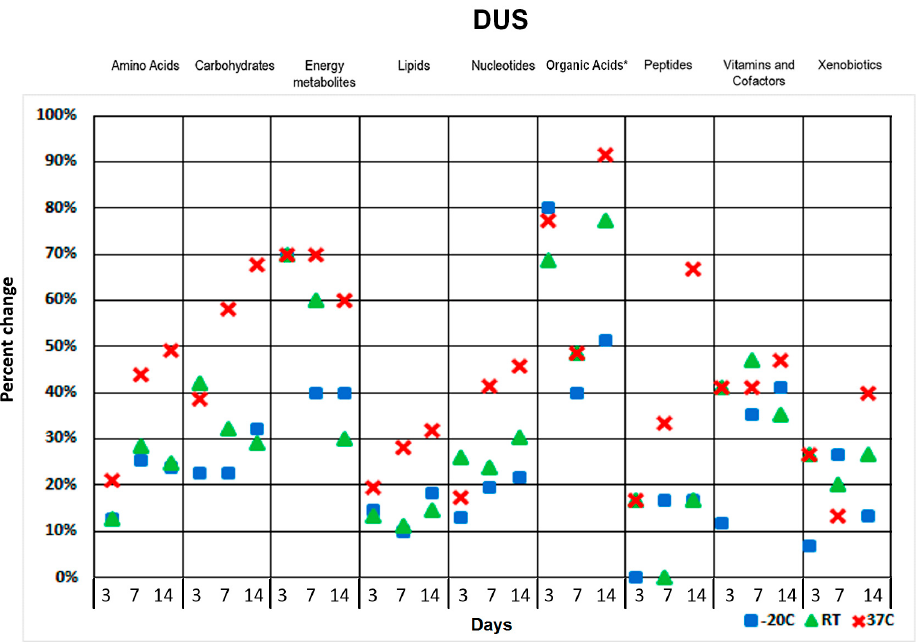
Figure 3. Two weeks DUS storage stability results for detected human urine metabolite classes. *—organic acids were measured with GC-MS protocols. Y axis represents percent change calculated using mean of triplicate measurements for a metabolite class. Each column shows three measurement points at 3, 7 and 14 days (from left to right).